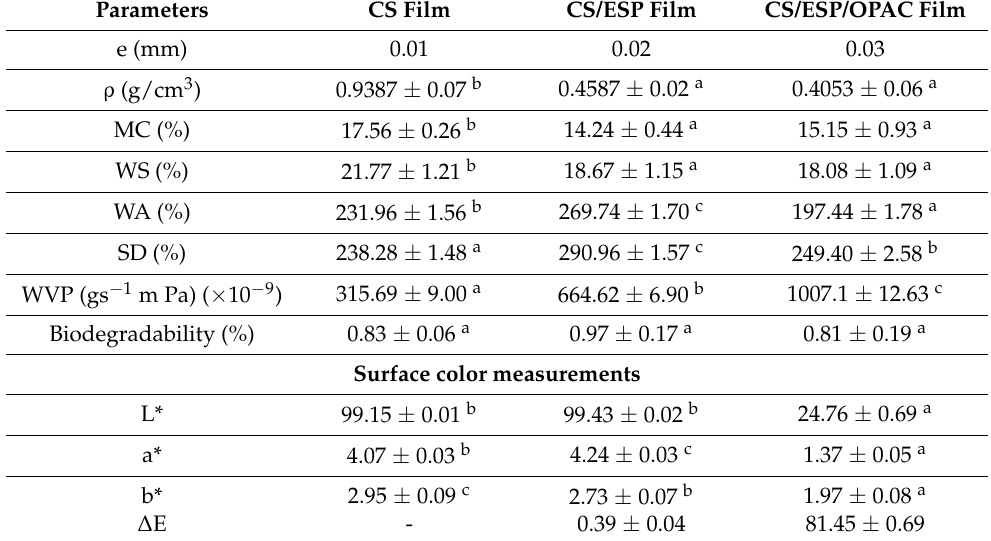
Table 1. Different parameters of different types of